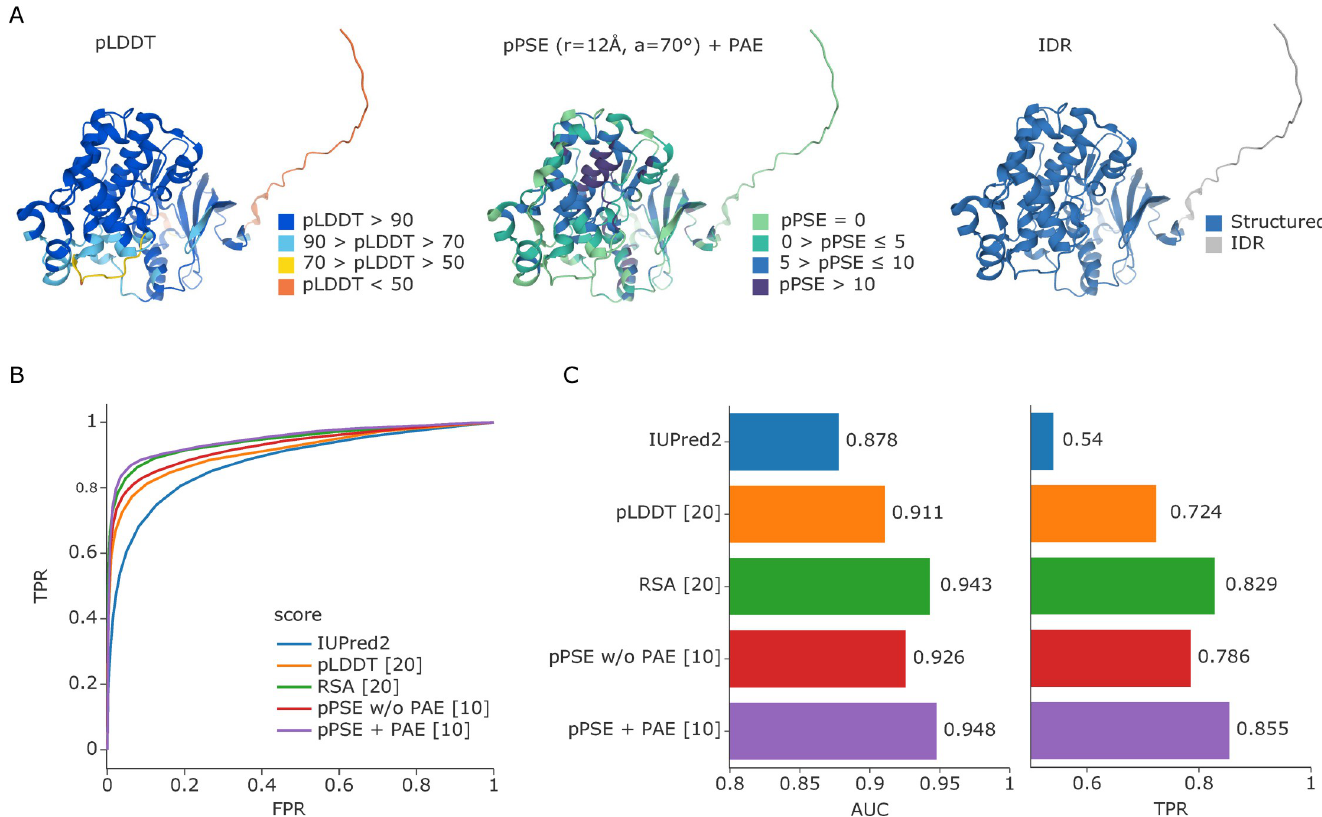
Fig 1. Estimation of amino acid side chain exposure and IDRs. (A) AlphaFold predicted structure of MAPK3 colored by prediction confidence (pLDDT, left), colored by our pPSE metric using a radius of 12 Å and an angle of 70˚ (center), and colored by our prediction of structured regions and IDRs (right). (B) ROC curve for predicting IDRs based on IUPred2 in comparison to the smoothed pLDDT confidence scores from AlphaFold, the smoothed RSAs, and the pPSE with (+) and without (w/o) considering the PAE (radius = 24 Å , angle = 70˚). (C) Corresponding AUC values and the TPRs at a 5% FPR. The numbers in square brackets behind each metric indicate the smoothing windows that were used; see S1 Fig for a comprehensive parameter screen. Source data for (B) and (C) are available at Github. AUC AU : AbbreviationlistshavebeencompiledforthoseusedinFigs 1 (cid:0) 5 : Pleaseverifythatallentriesarecorrect : , area under the curve; FPR, false positive rate; IDR, intrinsically disordered region; MAPK3, mitogen-activated protein kinase 3; PAE, predicted aligned error; pPSE, prediction-aware part-sphere exposure; ROC, receiver operating characteristice; RSA, relative solvent accessible surface area; TPR, true positive rate.